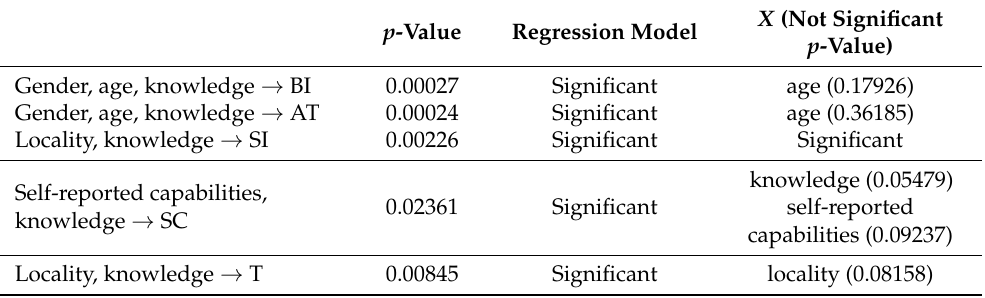
Table 17. Models with personal characteristics